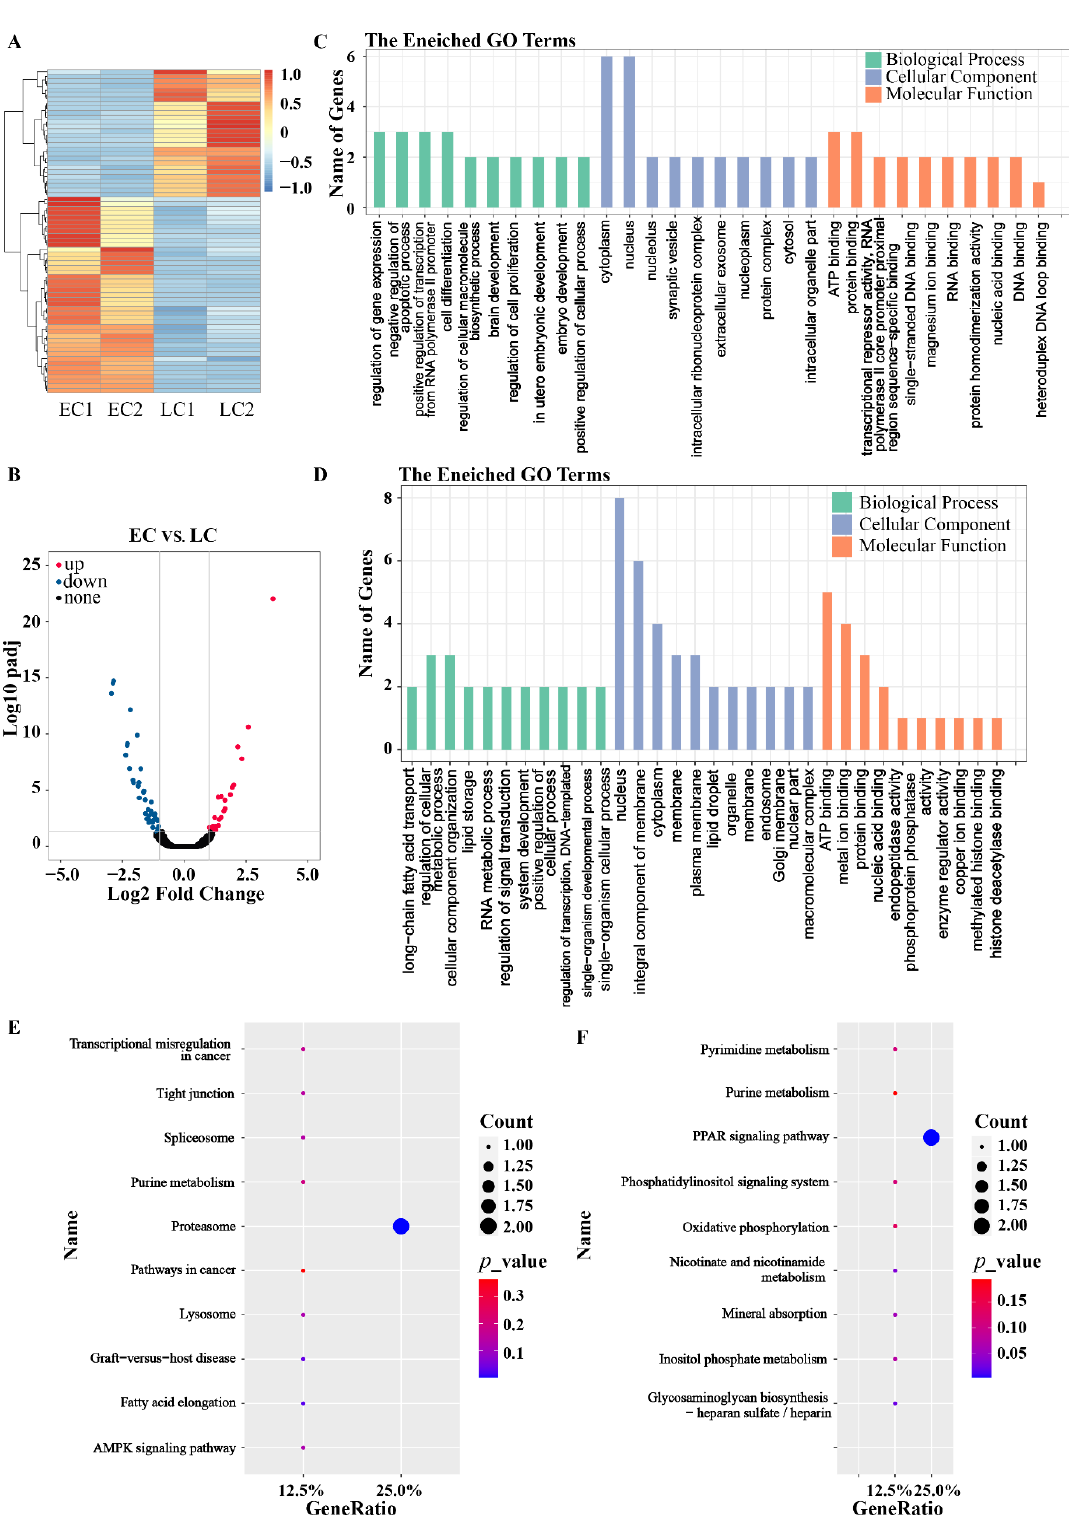
Figure 4. DEGs analysis between pig early cleavage embryos and late cleavage embryos of IVF with two repeats per group. ( A ). Volcano plot for DEGs between early and late cleavage pig IVF 2-cell embryos (|log 2 FC| ≥ 1, FDR < 0.05). ( B ). Heatmaps of annotated DEGs in early and late cleavage pig IVF 2-cell embryos. GO enrichment analysis of ( C ) upregulated and ( D ) downregulated DEGs. KEGG pathway enrichment analysis of ( E ) upregulated and ( F ) downregulated